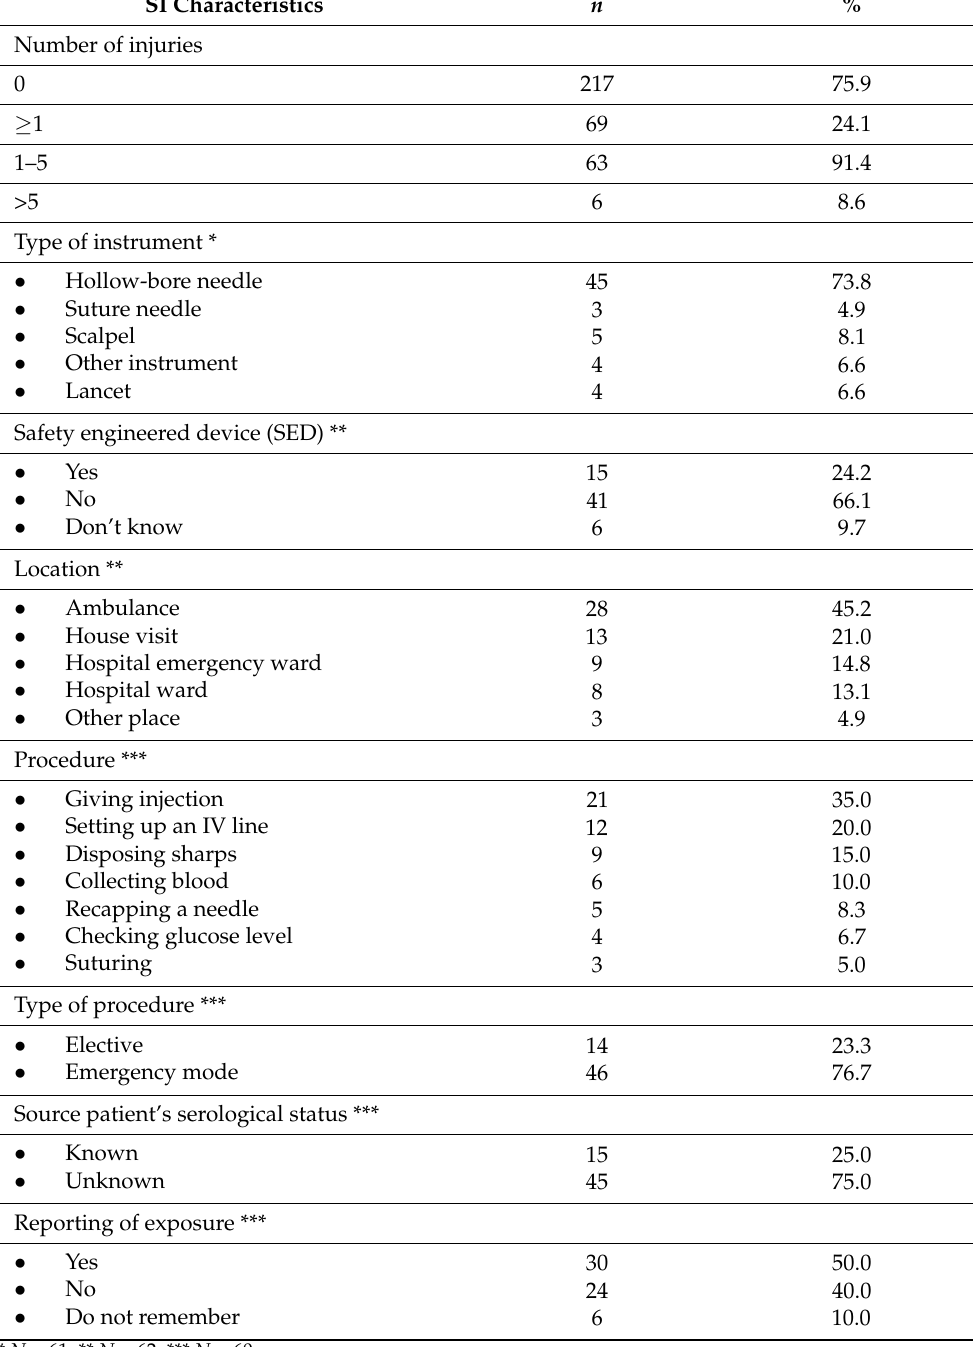
Table 2. Nature and frequency of sharp injuries (SIs) among paramedics; n = 286. SI